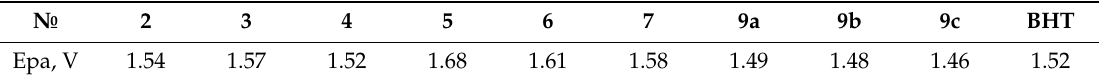
Table 1. Oxidation potentials (Epa) of compounds 2 – 7 , 9a –